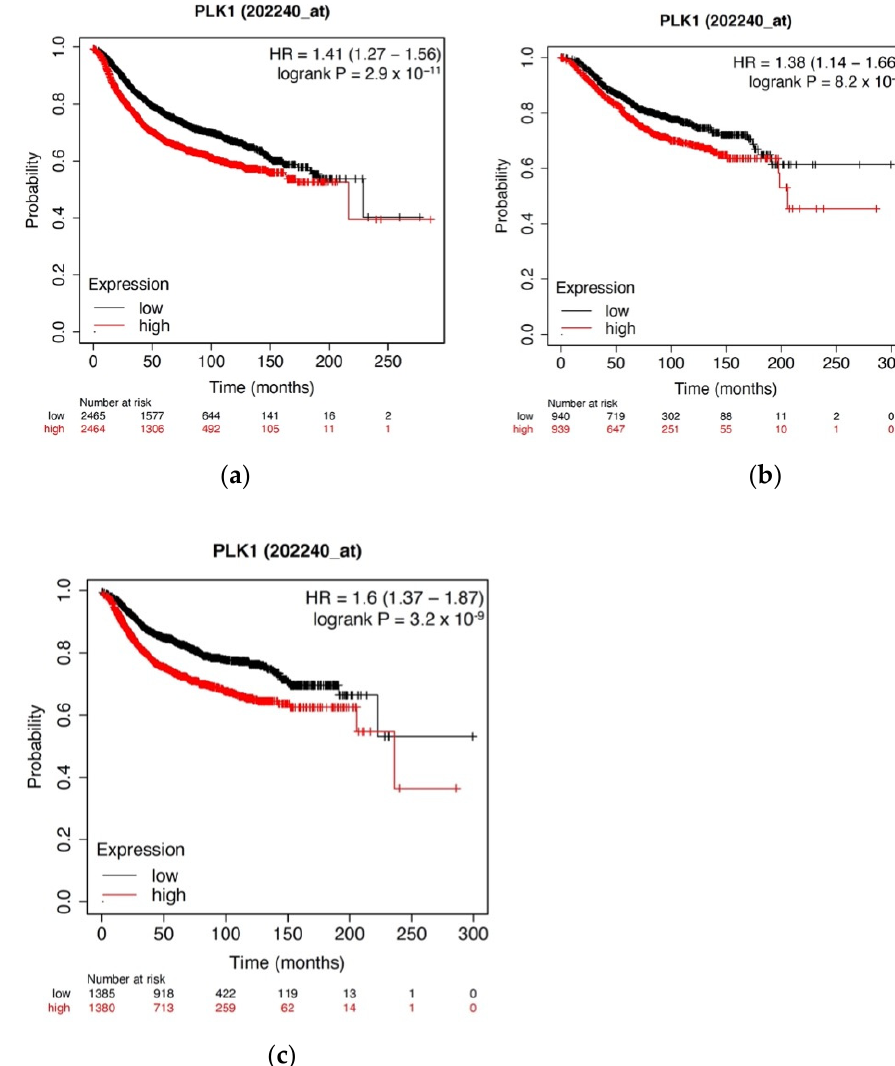
Figure 1. High PKL1 expression is positively associated with decreased RFS, OS, and DMFS in breast cancer patients. Kaplan–Meier plots of ( a ) RFS, ( b ) OS, and ( c ) DMFS based on PLK1 expression in breast cancer patients. Using Kaplan–Meier Plotter, publicly available microarray repositories for breast cancer were interrogated to determine whether PLK1 expression was associated with different survival rates among breast cancer patients. Hazard ratio (HR) and log-rank p -values are shown. Low PLK1 expression (below median) is noted in black; high PLK1 expression (above median) is noted in red.